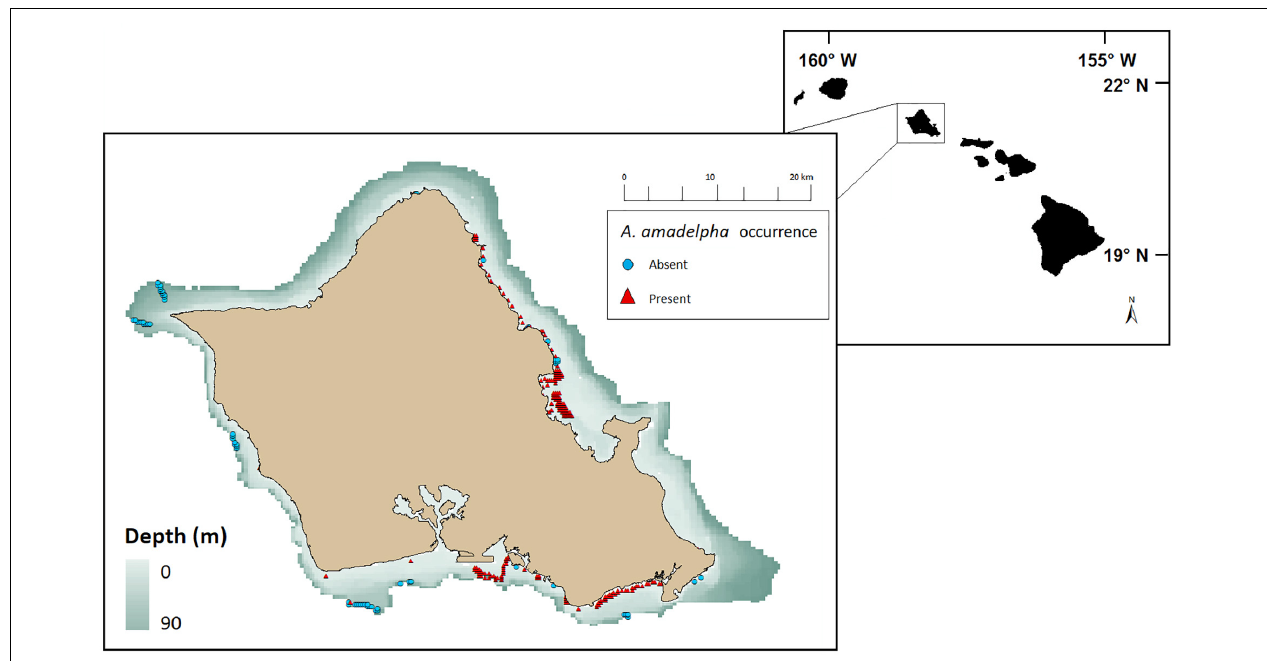
FIGURE 2 | Geolocated survey data denoting 23,421 observations of A. amadelpha occurrence around Oahu, Hawaii, from 2015 to 2017. Presence observations are demarcated with red triangles and absence observations are demarcated with blue circles. Observations edited for overlap at 250 m raster resolution scale and constrained to depths < 90 m.